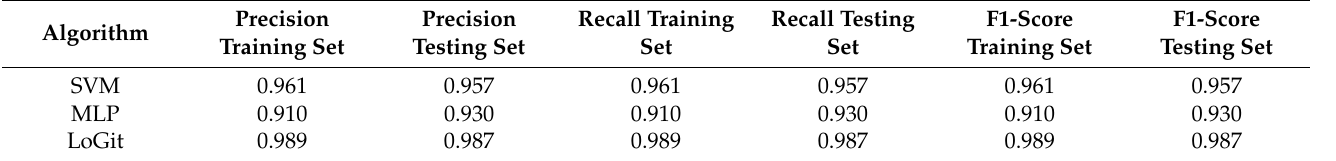
Table 3. Performance metrics of fine-tuned classification